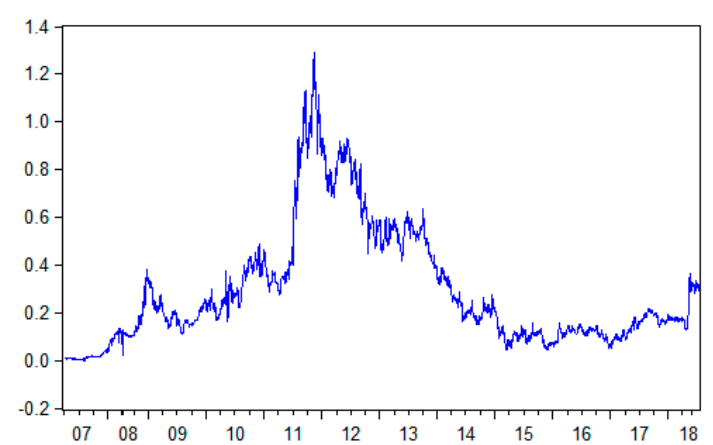
Figure 2. Quanto CDS spreads series: period Q2 2007–Q3 2018. Source: authors’ calculations based on Bloomberg data. Table 2. Descriptive statistics of data—extended model (EM).